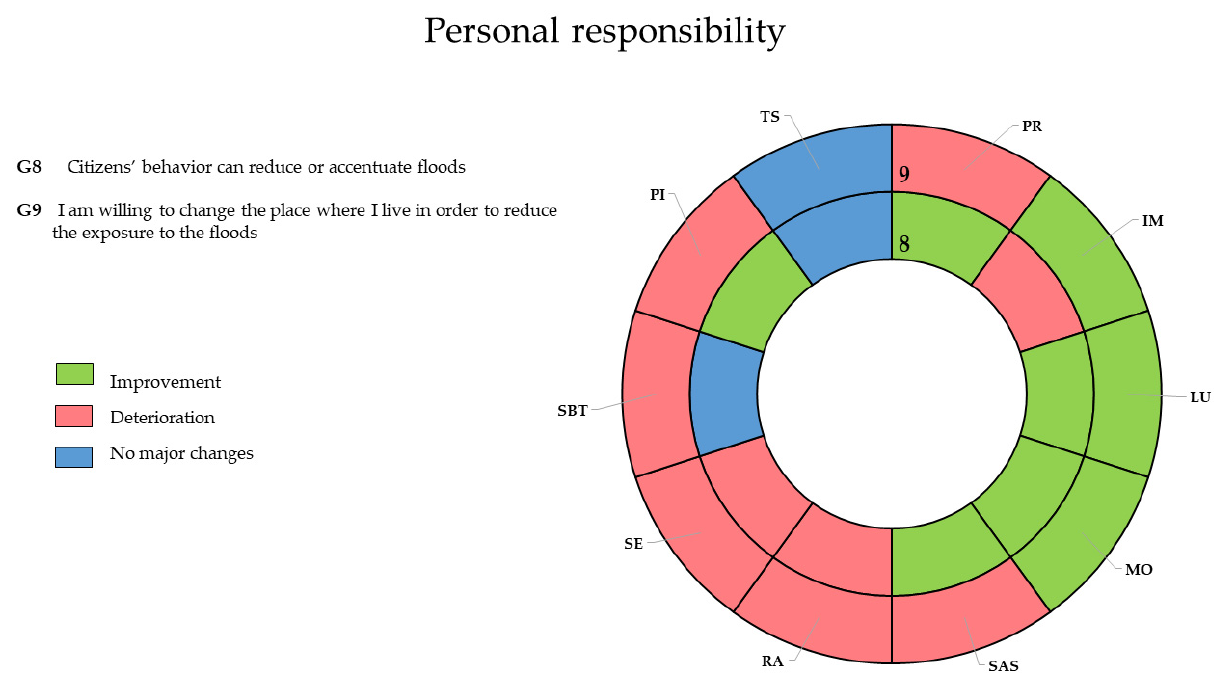
Figure 4. Representation of the effect of the LIFE PRIME project activities in shaping personal responsibility towards nature in the ten pilot areas (PR = Poggio Renatico; IM = Imola; LU = Lugo; MO = Mordano; SAS=Sant’Agata sul Santerno; RA = Ravenna; SE = Senigallia; SBT=San Benedetto del Tronto; PI = Pineto; TS = Torino di Sangro). Each question is represented as a circle numbered from G8 to G9 and colors represent the increase (green), decrease (pink), and absence of a change (blue) in personal responsibility between the two phases.